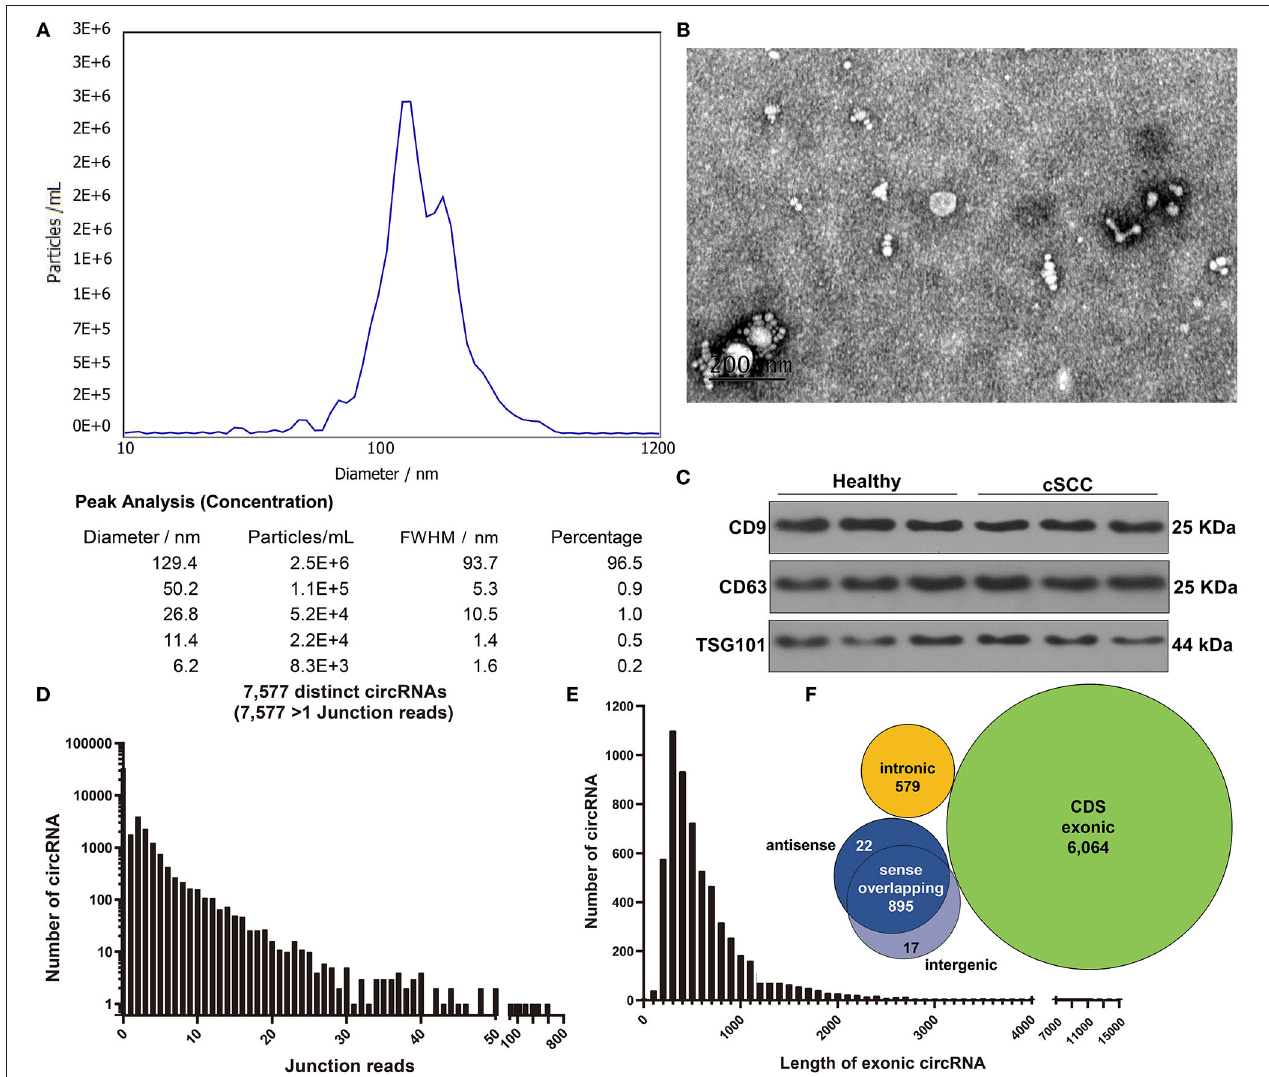
FIGURE 1 | Characterization of exosomes from plasma of cSCC and healthy subjects. (A) NTA for detection of the particle size of isolated exosomes. (B) TEM for the appearance of exosomes. Bar = 200nm. (C) Western blot for examining the expression of exosomal specific markers CD9 and CD63. (D) The junction reads of exosomal circRNAs. (E) The length of exonic circRNAs. (F) The genomic source of exosomal circRNAs.